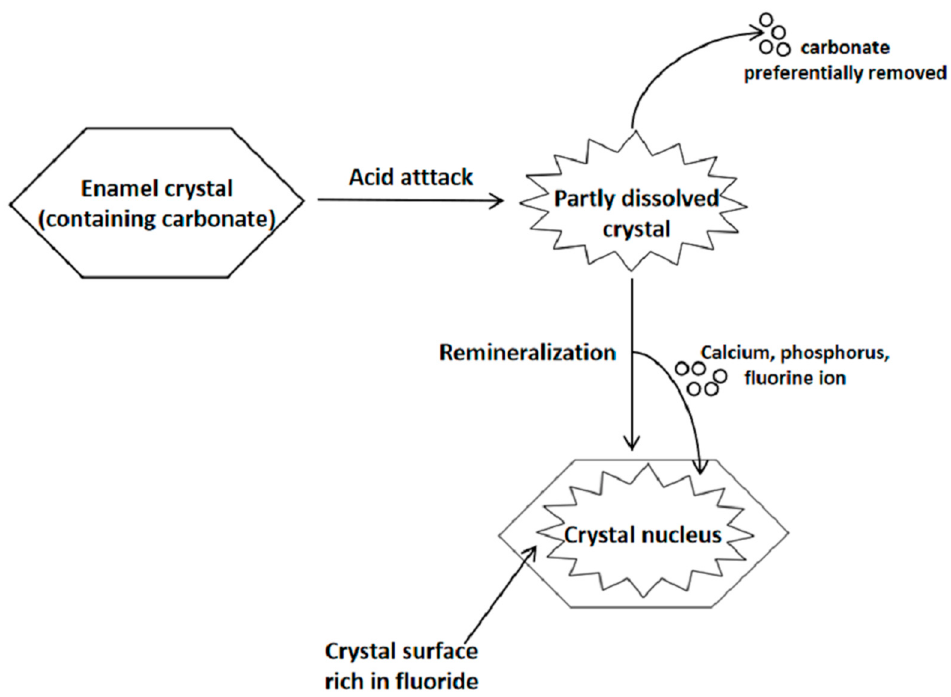
Figure 1. Schematic diagram of the de/remineralization process. The process of remineralization will yield fluoride-rich, carbonate-deficient enamel surfaces.